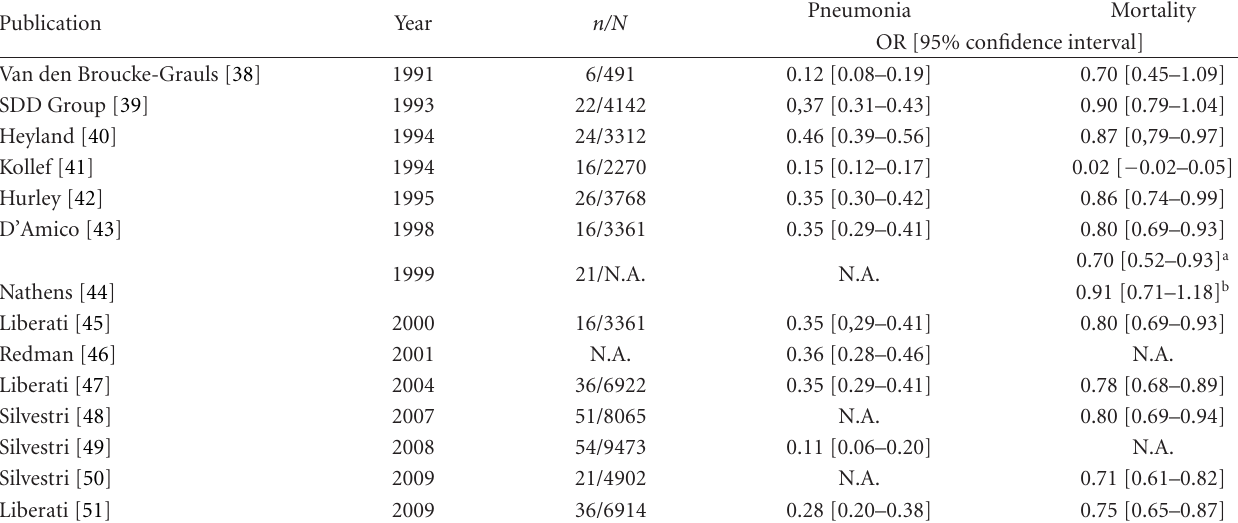
Table 3: Odds ratios for pneumonia and mortality in meta-analyses of trials of SDD.